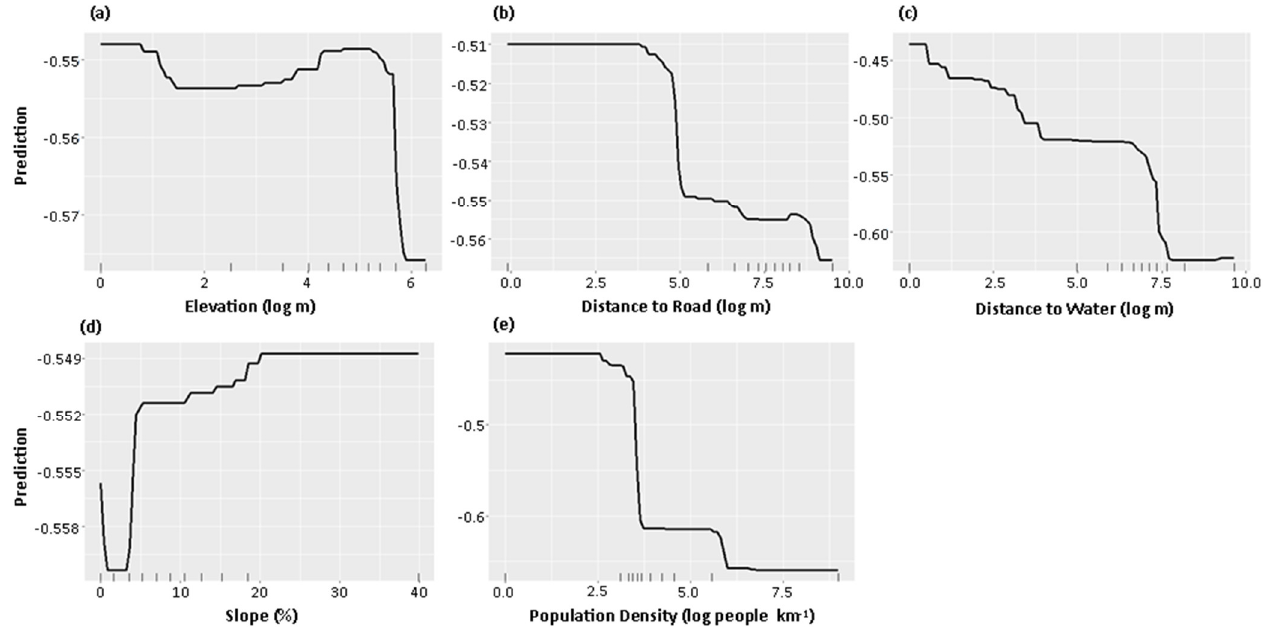
Figure 2. Partial dependence plots of a boosted regression tree analysis showing the relationships between the prediction of leopard cat occurrence and five major predictors. Those five predictors are: ( a ) elevation (relative influence: 15.3%) ( b ) distance to road (15.2%), ( c ) distance to water (15.1%), ( d ) slope (14.2%), ( e ) population density (13.5%), respectively. Table 2. Summary of logistic regression analysis. The notation of variables was described in Table 1 (SE: standard